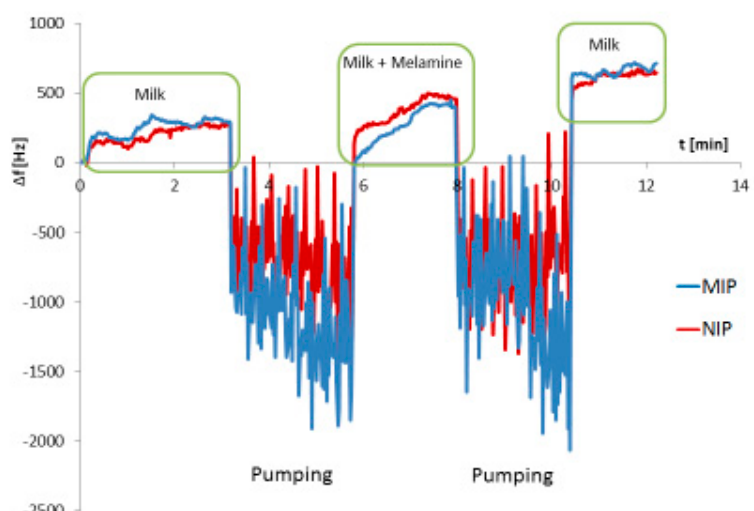
Figure 3. QCM measurement of melamine saturated milk (0.5% fat). Because of unknown matrix effects, there is no significant signal of melamine visible (green boxes). The enormous noise signals are due to the pumping of milk.